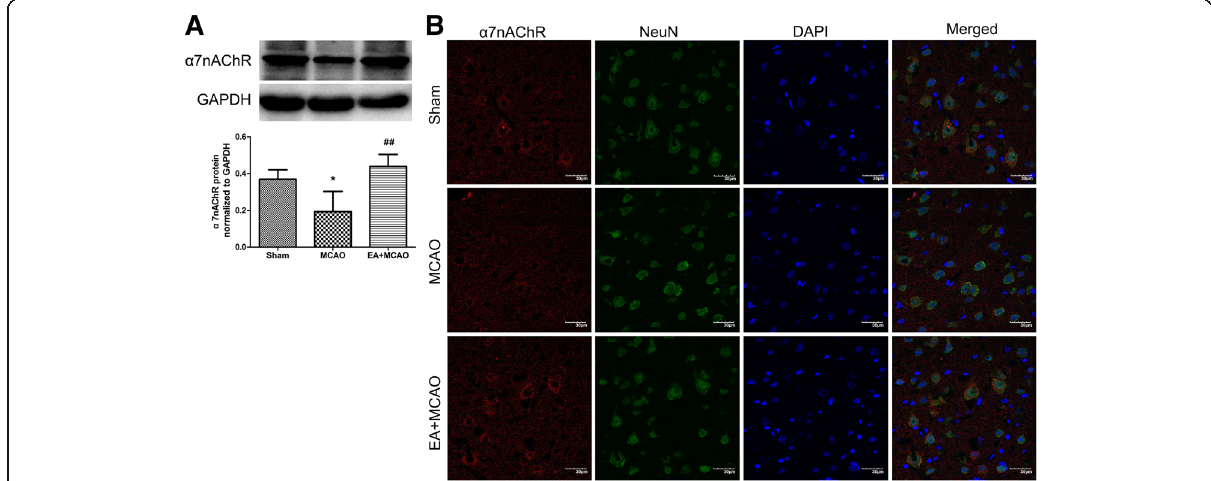
Fig. 4 Effect of EA stimulus on the expression of α 7nAChR. a Compared with sham group, the cerebral I/R injury decreased the contents of α 7nAChR. Meanwhile, the EA up-regulated the contents of α 7nAChR compared with MCAO group. * P <0.05 vs. Sham group, ## P <0.01 vs. MCAO group. b Representative immunofluorescent staining of α 7nAChR, neuronal nuclei (NeuN), and nuclear marker DAPI. Cerebral I/R injury decreased the levels of α 7nAChR-positive neurons compared with Sham group, while EA up-regulated the contents of α 7nAChR-positive neurons when compared with MCAO group. Scale bar=30 μ